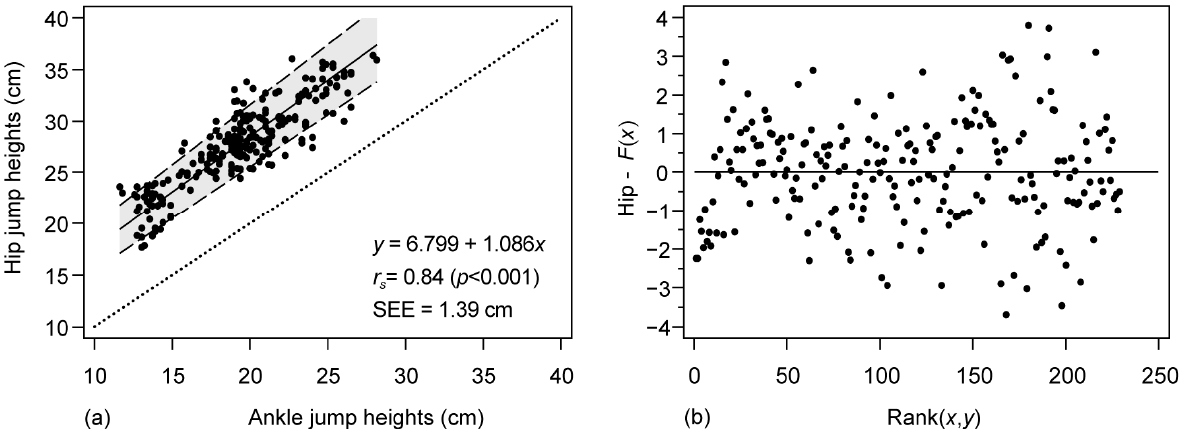
Figure 3. Correlation analysis between the Vmaxpro devices placed on hip and ankle through Passing and Bablok regression and residual plot. ( a ) Regression analysis. Solid line: fitted line; dashed lines: 95% CI of the fitted line; dotted line: perfect agreement line, x = y ; r s : Spearman’s correlation coefficient; SEE: standard error of the estimate. ( b ) Residuals plot.